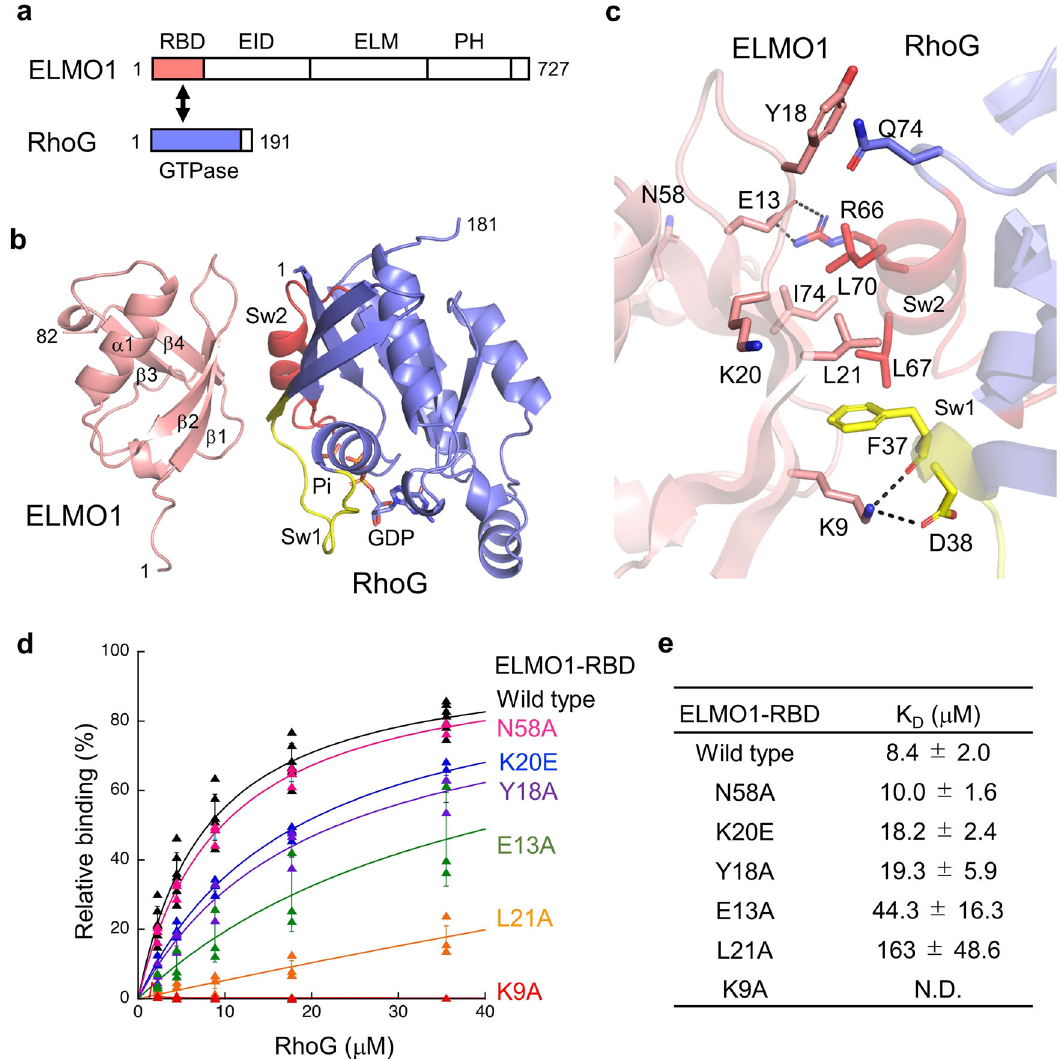
Fig. 1 Structure of ELMO1-RBD and its binding to RhoG. a Domain organizations of ELMO1 and RhoG. RBD Ras-binding domain, EID ELMO-inhibitory domain, ELM ELMO domain, PH Pleckstrin homology domain. Regions not included in the construct are shown as white boxes. b Overviews of the crystal structure of the ELMO1-RBD and RhoG complex. ELMO1-RBD is shown in salmon and RhoG in blue except for switch 1 (Sw1, yellow) and switch 2 (Sw2, red), and bound GDP and Pi are shown as sticks. c Interface between ELMO1-RBD and RhoG. Key interacting residues are indicated by stick models. d SPR binding analysis between ELMO1-RBD (wild-type and mutants) and RhoG. e K D values of ELMO1-RBD for RhoG estimated from SPR binding assay. Data are means ± s.d. ( n = 3 independent